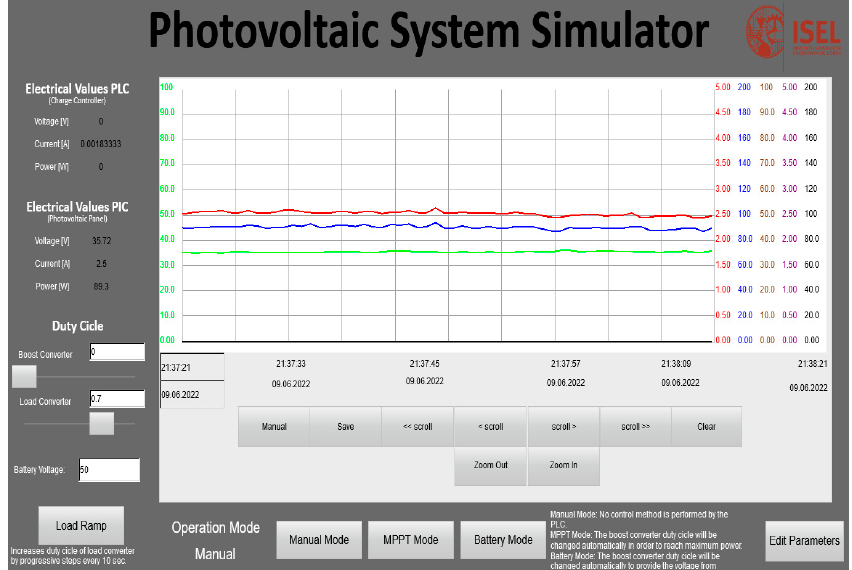
Figure 23. SCADA software layout developed to present and record data (voltage (green line), current (red line), power (blue line)) obtained by the PLC during experimental tests.